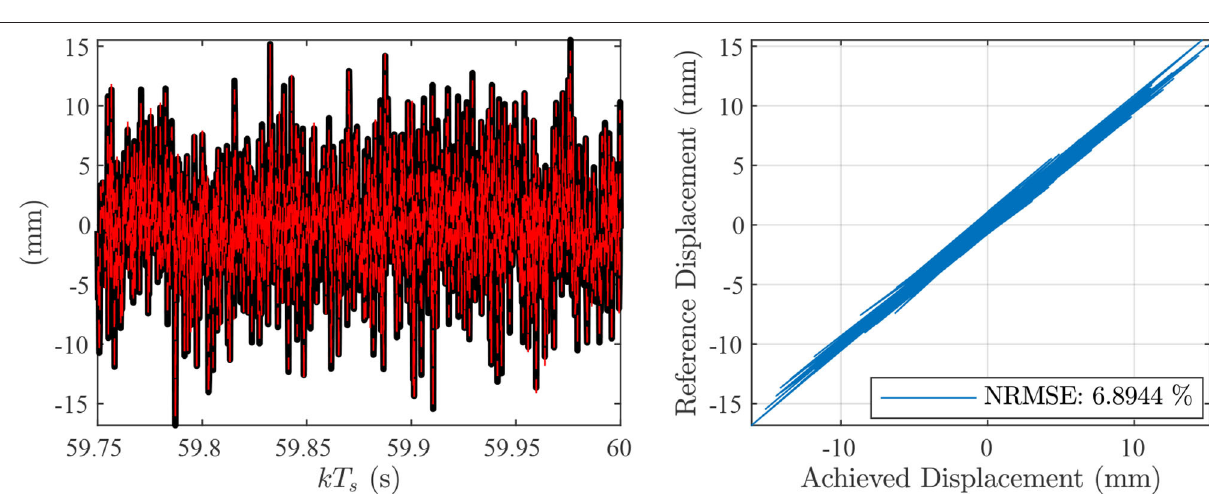
FIGURE 9 | Left : delayed reference (continuous black line) and achieved (dashed red line) signals during the last 0.25 s of the adaptation process. Right : synchronization plot of the signals on the left. NRMS, normalized root means square error ( Figure 7